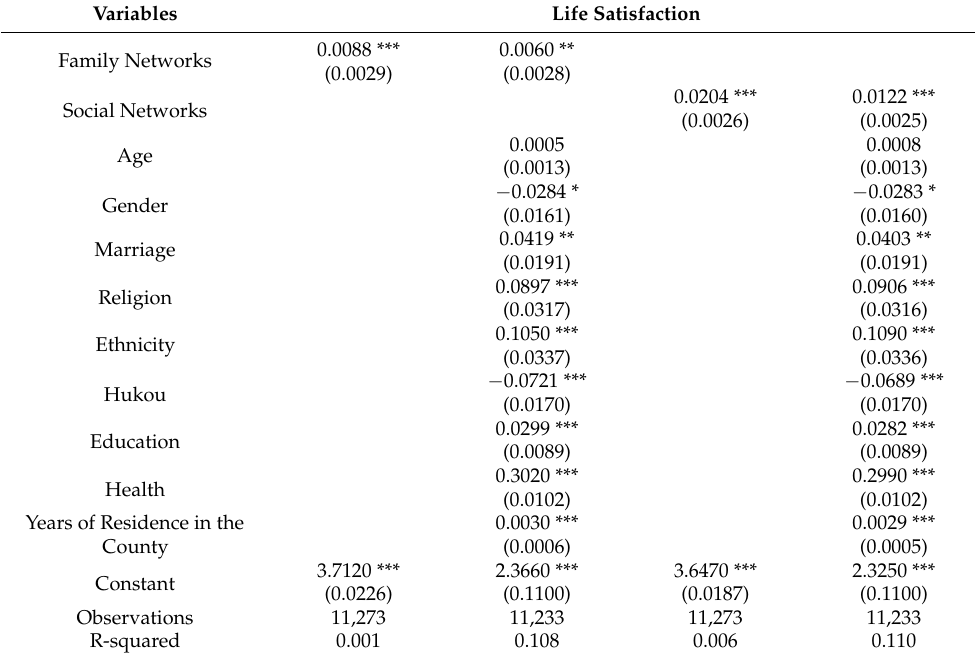
Table 3. Univariate regression